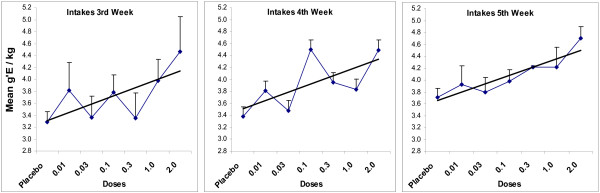
Mean Grams of Ethanol Taken Daily during Weekly Presentation of Alcoholic Beverage. This figure presents a summary of the effects of the various doses on intake of alcoholic beverages by presenting the mean weekly intake of the females during the 3rd, 4th and 5th week of presentation of alcoholic beverage. The data point labelled placebo is the mean of the groups getting no EV and the two groups getting the smallest doses of EV (0.001 and 0.003 mg/female). The bars are standard errors of the mean. The lines without data-points are trend lines of best fit to the data.